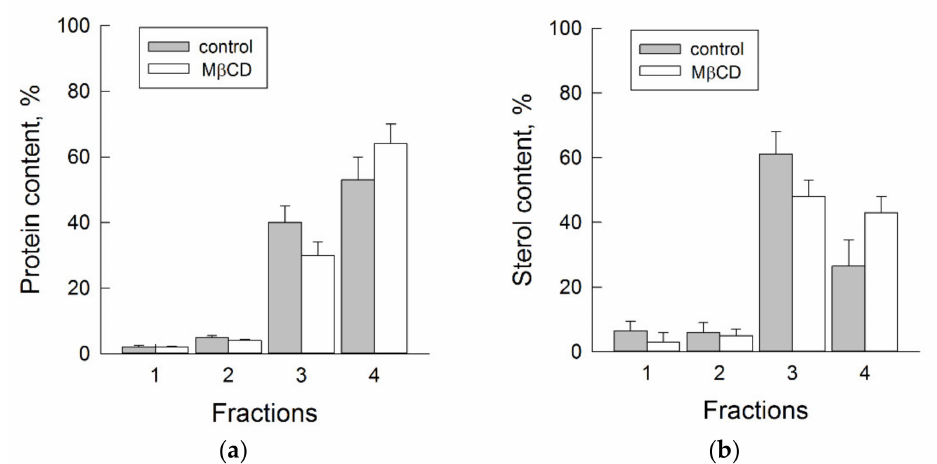
Figure 6. Effects of M β CD on protein ( a ) and sterol ( b ) distribution between Triton X-100-solubilized plasma membrane fractions obtained after their floatation in iodixanol density gradient. All gathered protein/sterol contents after centrifugation were taken as 100%. Fractions 1–4 corresponded to 1.079, 1.127, 1.156, and 1.185 g cm − 3 , respectively. Plasma membranes were pretreated with 10 mM M β CD before adding Triton X-100.